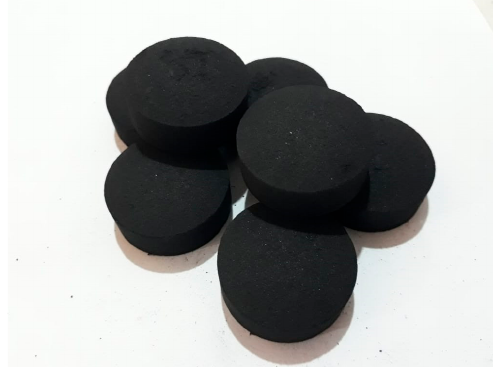
Figure 10. Fabricated combustible briquettes. Table 5. Immediate analysis of the sludge generated in the treatment of the